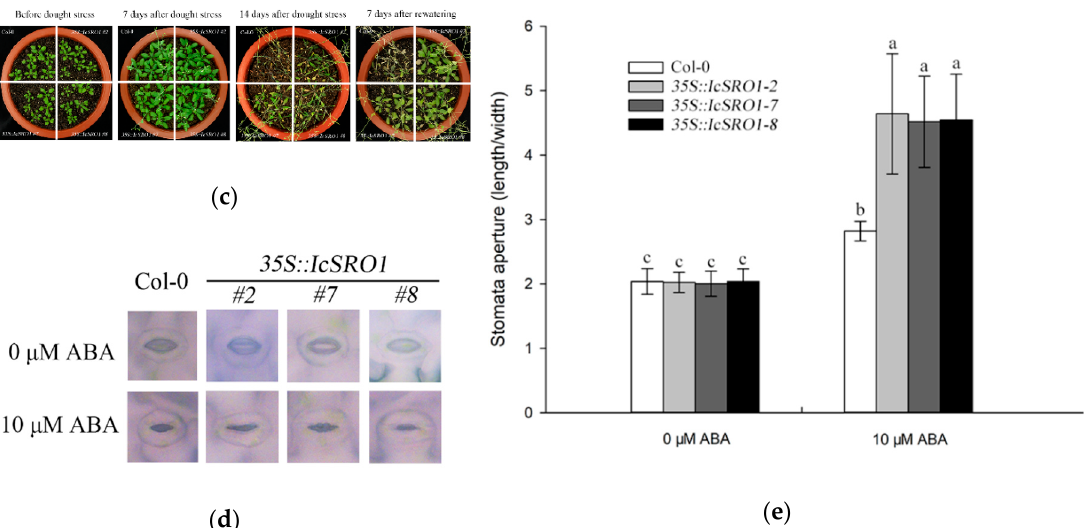
Figure 6. Overexpressed IcSRO1 in transgenic Arabidopsis improves plant adaptation to salinity and drought stress and reduced the sensitivity to exogenous ABA. ( a ) The transgenic Arabidopsis and Col-0 seedings were sown on medium containing 0, 150 mM NaCl, and 1 µ M ABA. ( b ) Length of primary roots was calculated in the transgenic and Col-0 seedings. ( c ) Drought treatments along with rewetting were applied to 2-week-old transgenic and Col-0 plants. ( d , e ) Stomatal aperture measurement of Col-0 and IcSRO1 transgenic plants in response to 0 and 10 µ mol / L ABA. All the data represent the means ± SDs. The di ff erent letters in the bar graphs indicate significant di ff erences at p < 0.05.